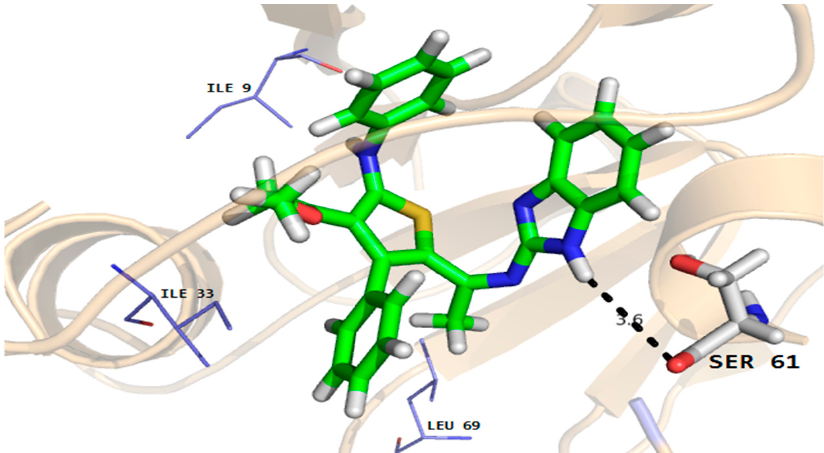
Figure 6. Molecular docking conformation of compound 5 in the active site of rhomboid protease of E. coli (PDB ID 3ZMI) showing hydrogen bonding, hydrophobic and van der Waals interactions.